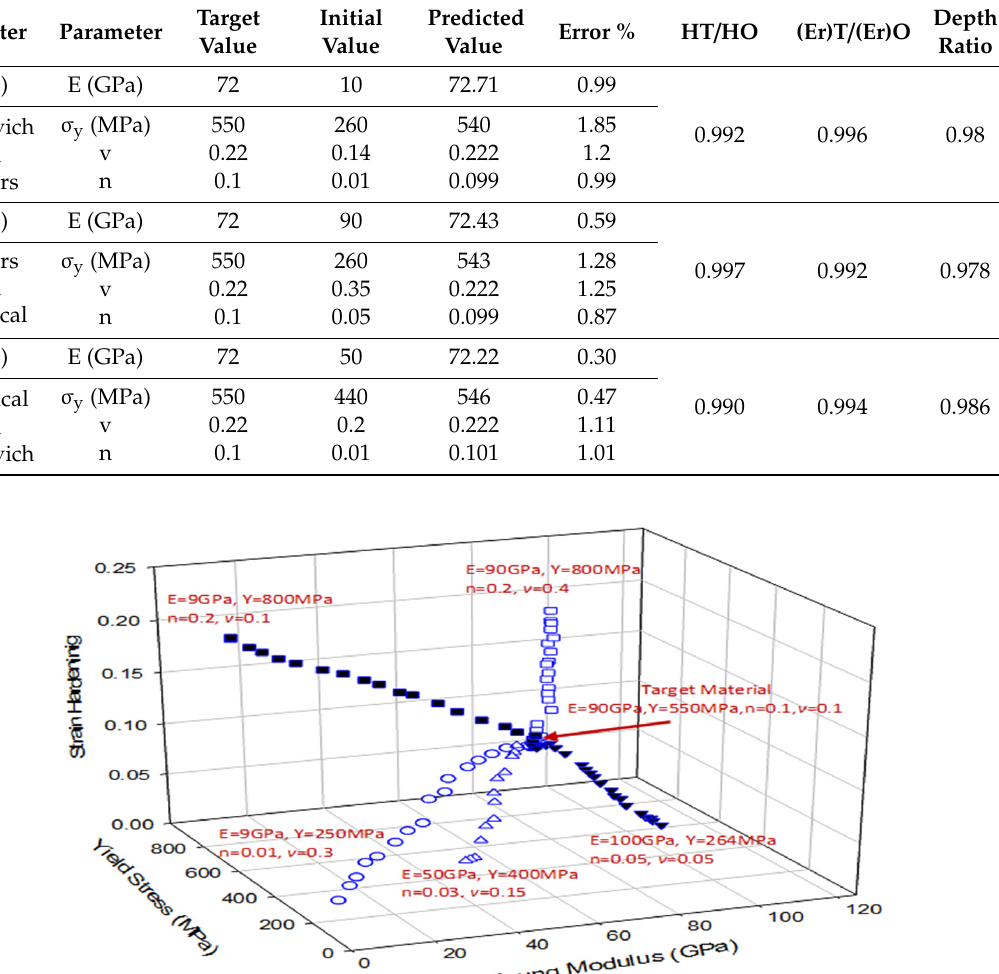
Table 1. Dual indenter optimization results of elastic plastic material. HT / HO = target indentation